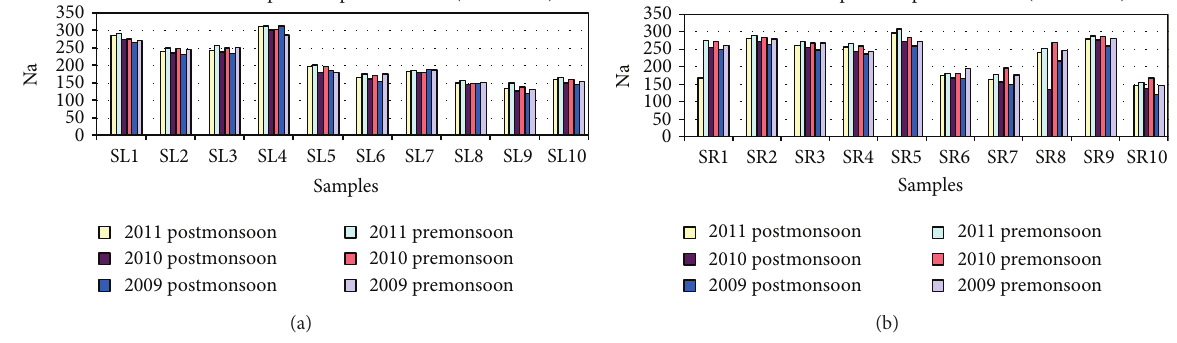
Figure 7: (a) Observations of Na in water from the sites SL1–SL10 for the pre- and postmonsoon of 2009–2011. (b) Observations of Na in water from the sites SL1–SL10 for the pre- and postmonsoon of 2009–2011.